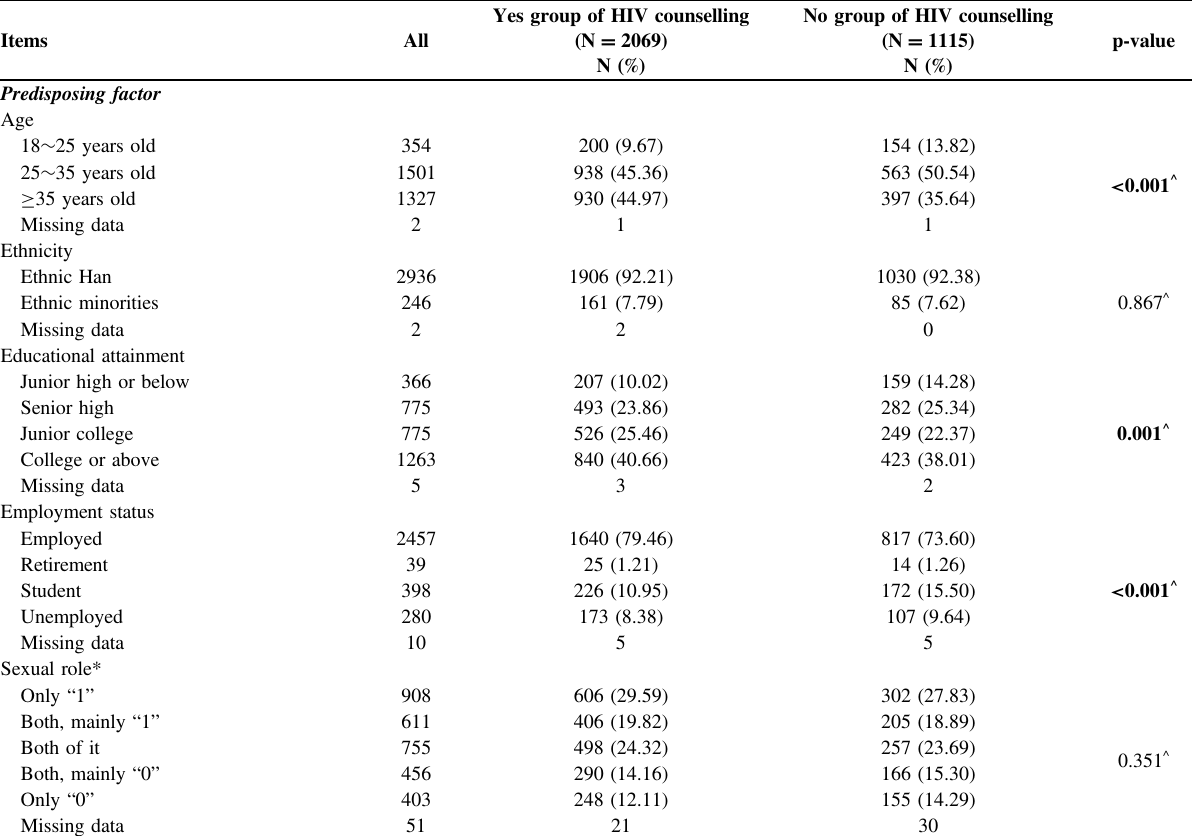
Table 2 Univariate analysis of HIV counselling service (N =